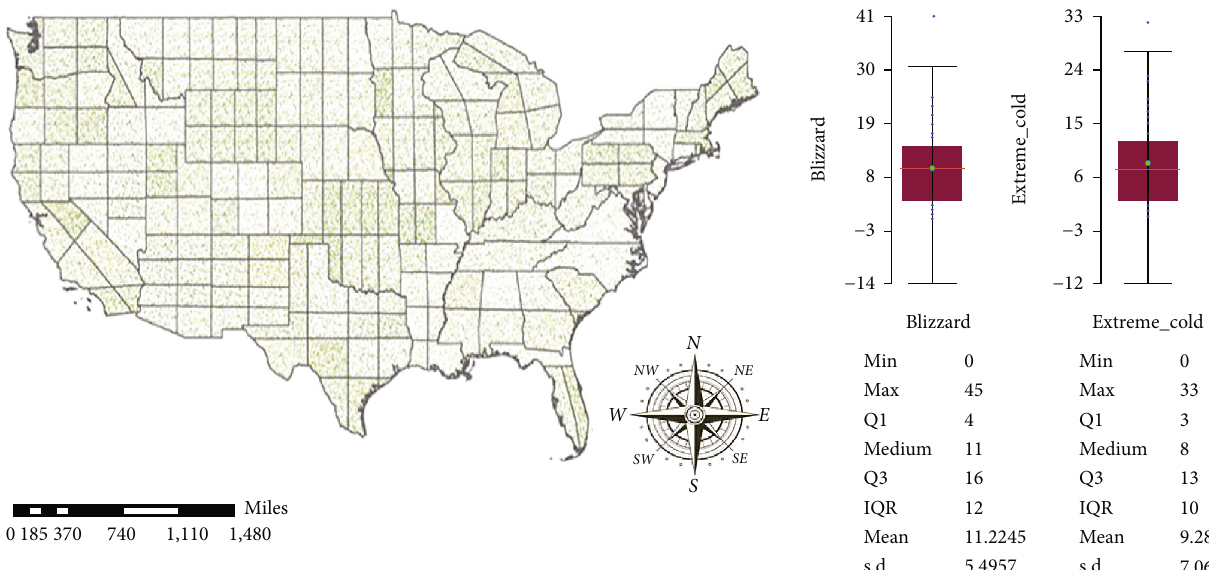
Figure 6: Blizzard and extreme cold/wind chill event correlation